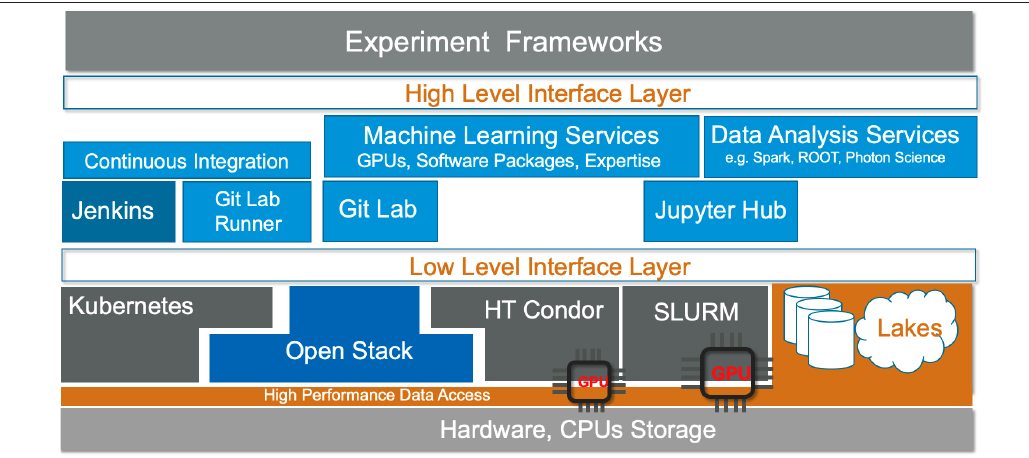
Figure 1. One possible vision of the setup of the IDAF: How the di ff erent layers and technologies interact, and interface to the